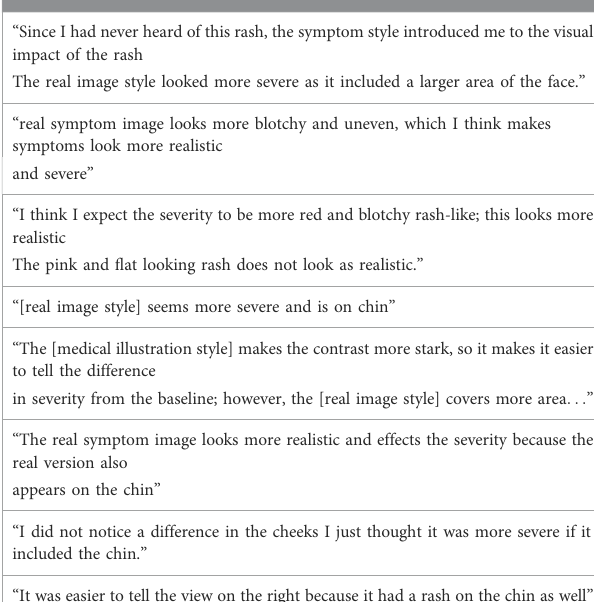
TABLE 8 Example responses regarding rash pattern. Example responses regarding rash